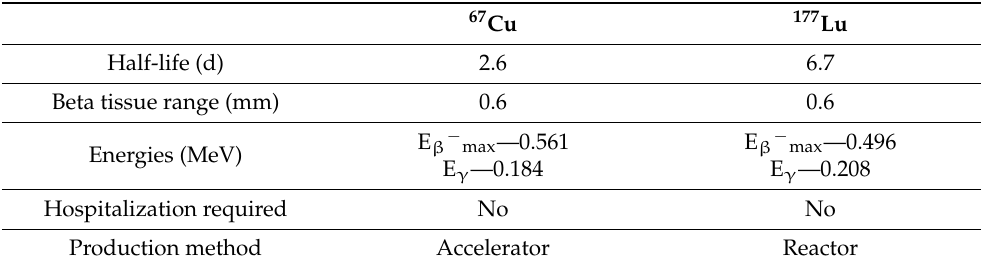
Table 3. Comparison of characteristics of radionuclide 67 Cu and 177 Lu.